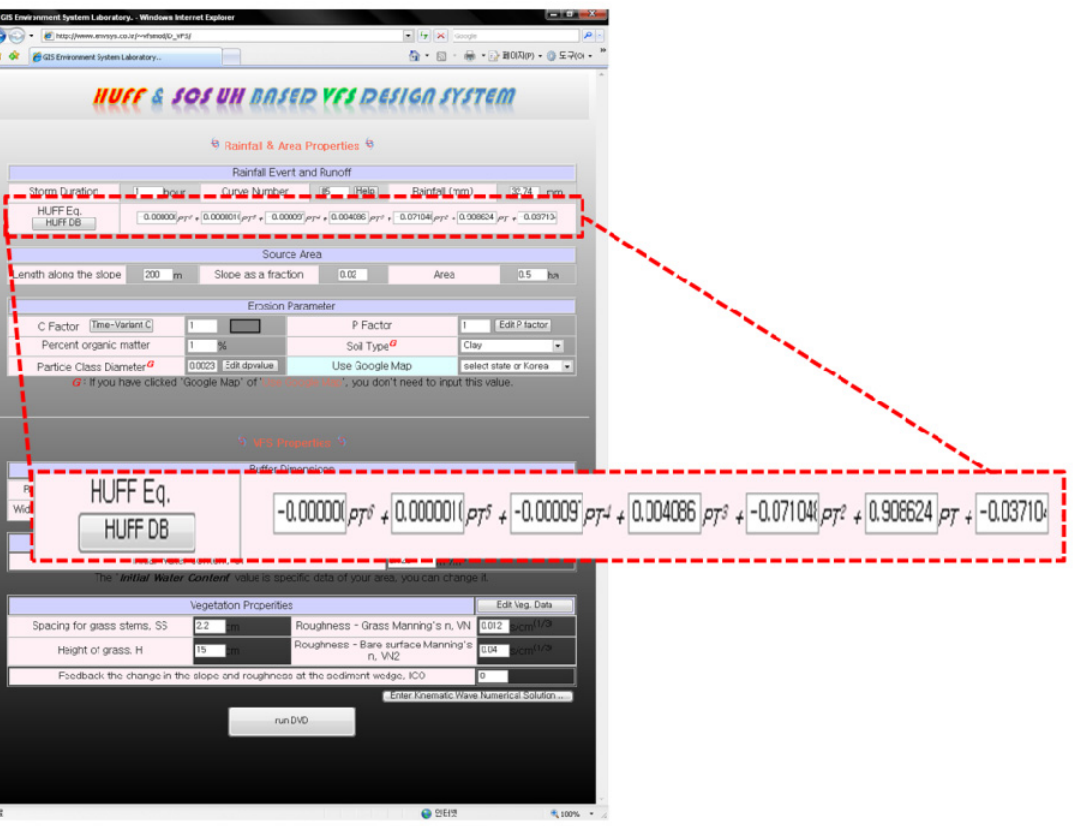
Figure 7. HUFF & SCS UH-based VFS design module using Huff